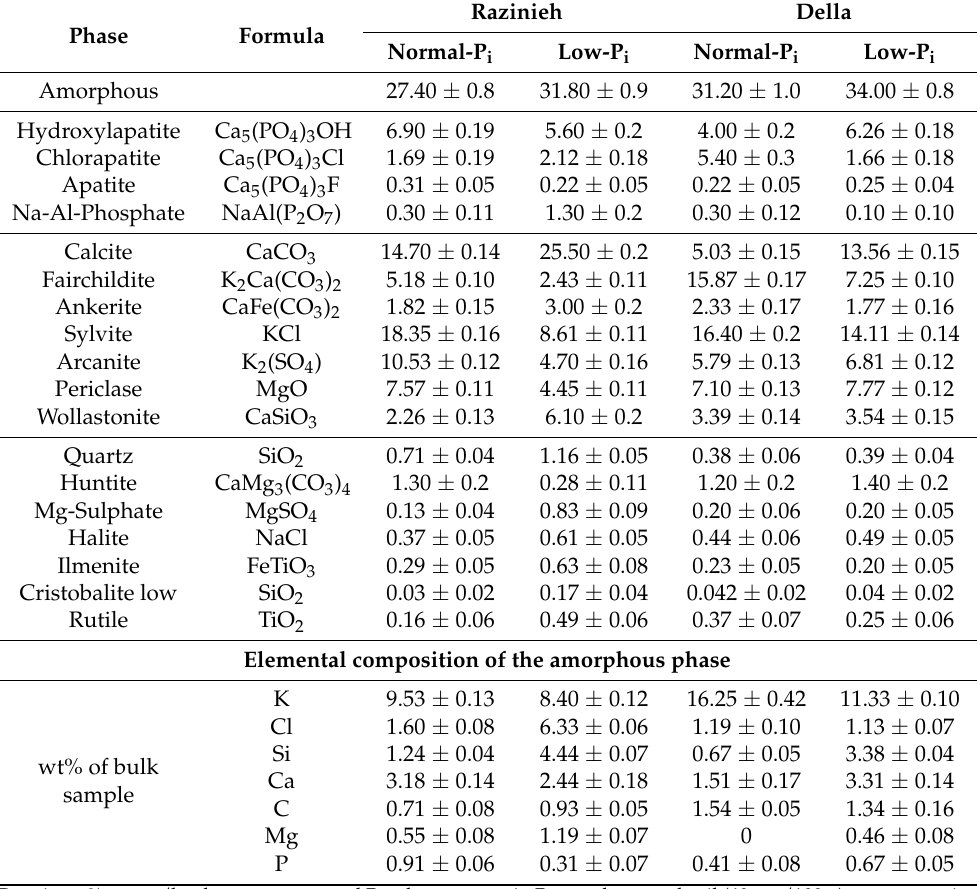
Table 3. Rietveld refinement data of XRD for plant ashes (produced at 550 ◦ C) obtained from the straw of a grain (Razinieh) and a sweet (Della) sorghum variety grown under P i starvation